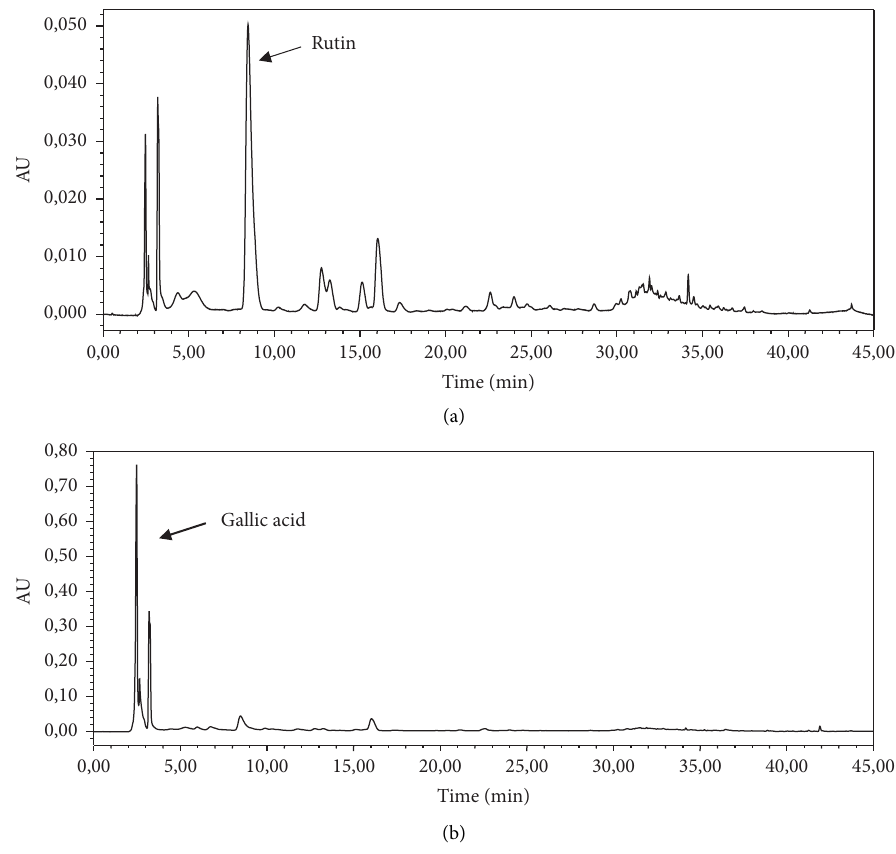
Figure 1: HPLC profles of walnut bark extract obtained at 365nm (a) and 283nm